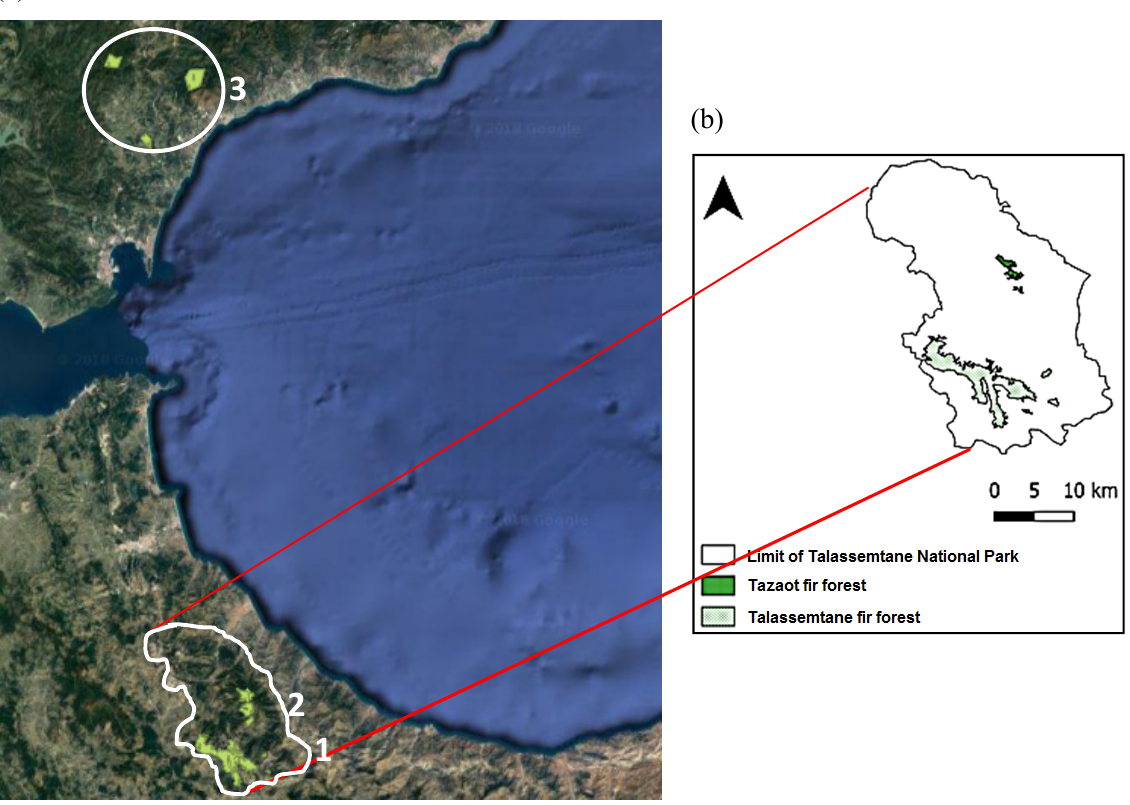
Figure 3. a, geographical location of Moroccan fir (1: Talassemtane fir, 2: Tazaout fir) and Spanish fir (3); b, Talassemtane and Tazaout forests within the Talassemtane National Park in western Rif Mountains (Northern